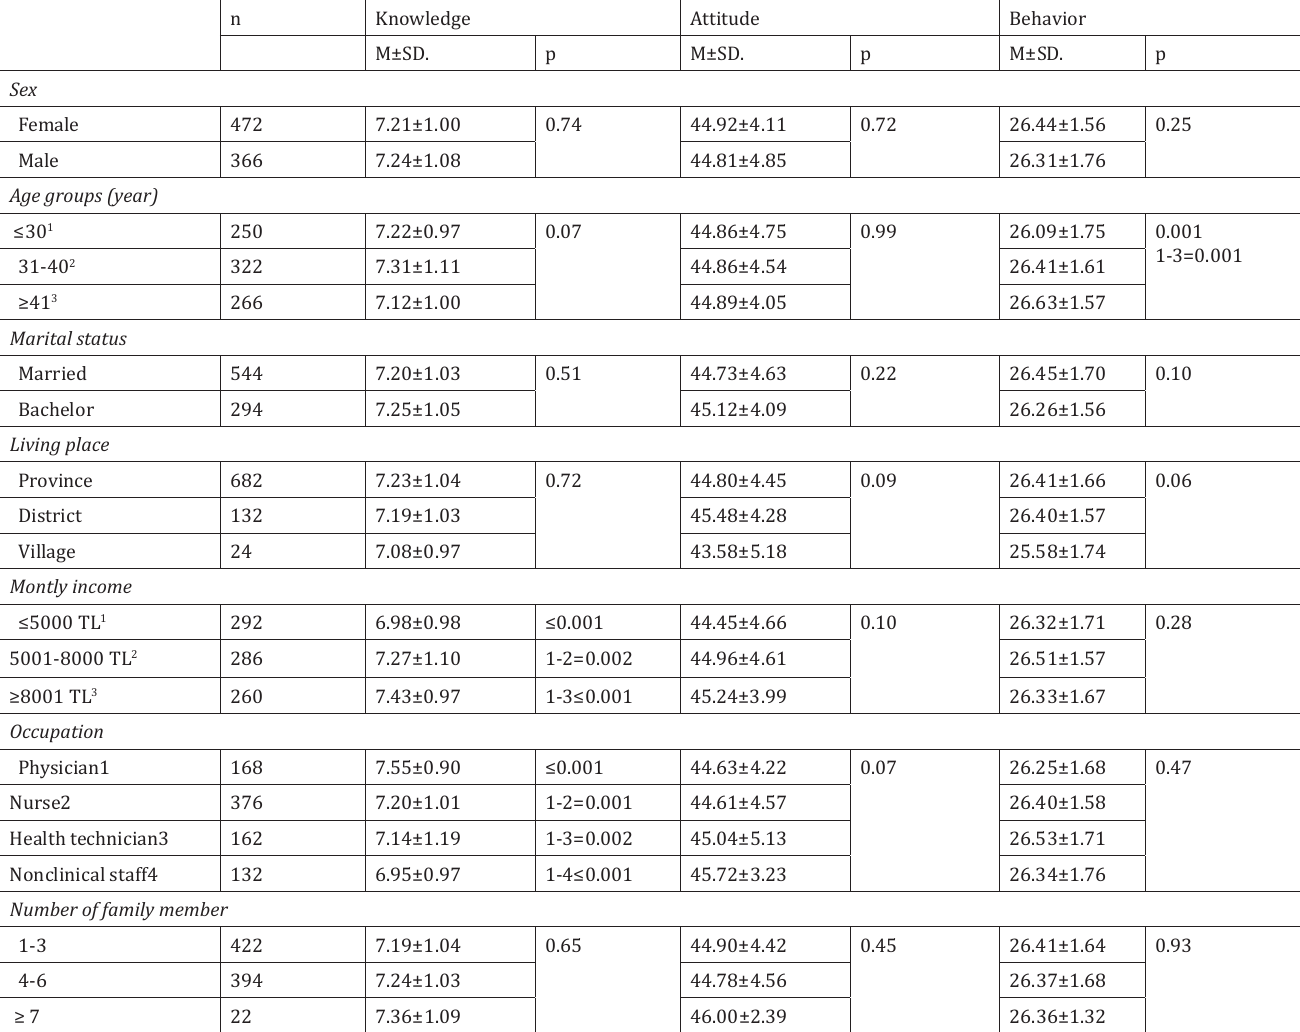
Knowledge, attitude and behavior towards COVID-19 according to sociodemographic characteristics of health